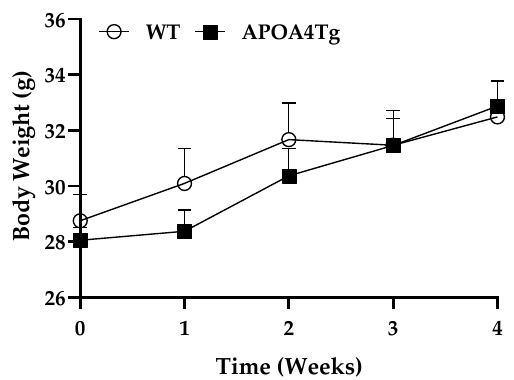
Figure 3. Levels of plasma apolipoproteins ( A ), thermogenic protein ( B ), tyrosine hydroxylase (TH) protein ( C ), adipose triglycerides lipase (ATGL) protein ( D ), hormone-sensitive lipase (HSL) protein ( E ) and mRNA ( F ) in BAT of mice fed HFD for 4 weeks, and weekly body weight ( G ) in WT and APOA4-Tg mice during a 4-week feeding of HFD at 28 °C. Plasma and BAT were collected after a 5 h fast. Plasma APOA4 or APOA1 in WT mice was considered as 100%. Data are expressed as mean ± SEM for 6–8 animals per group. Values with asterisks (*) represent significant differences relative to the WT mice ( p < 0.05). Table 2. Body weight, fat mass, and levels of plasma parameters in mice fed an HFD for 4 weeks.